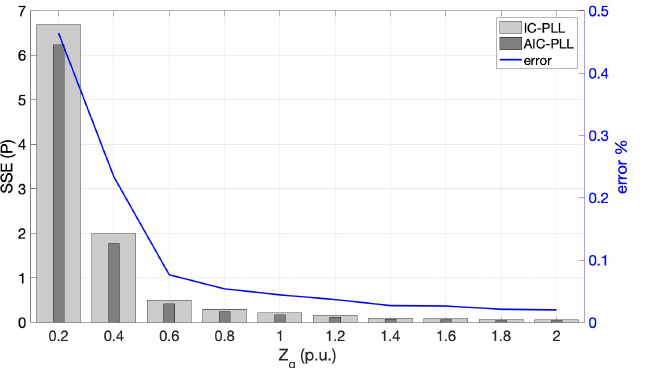
Figure 19. SSE for the active power tracking for the IC-PLL- and AIC-PLL-based system for different change in the values of the grid impedance (rectifier